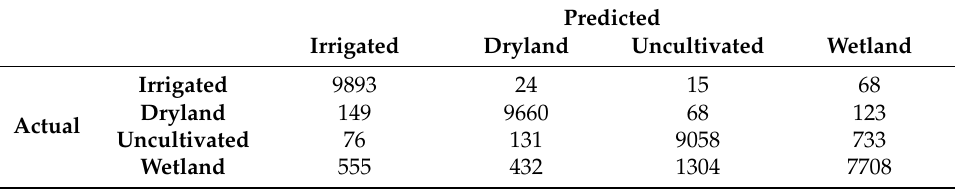
Table 2. Confusion matrix of the four-class cross validation dataset, comparing the spatially independent, randomly sampled cross validation dataset of training data (i.e., ‘Actual’) and IrrMapper inference (i.e., ‘Predicted’).